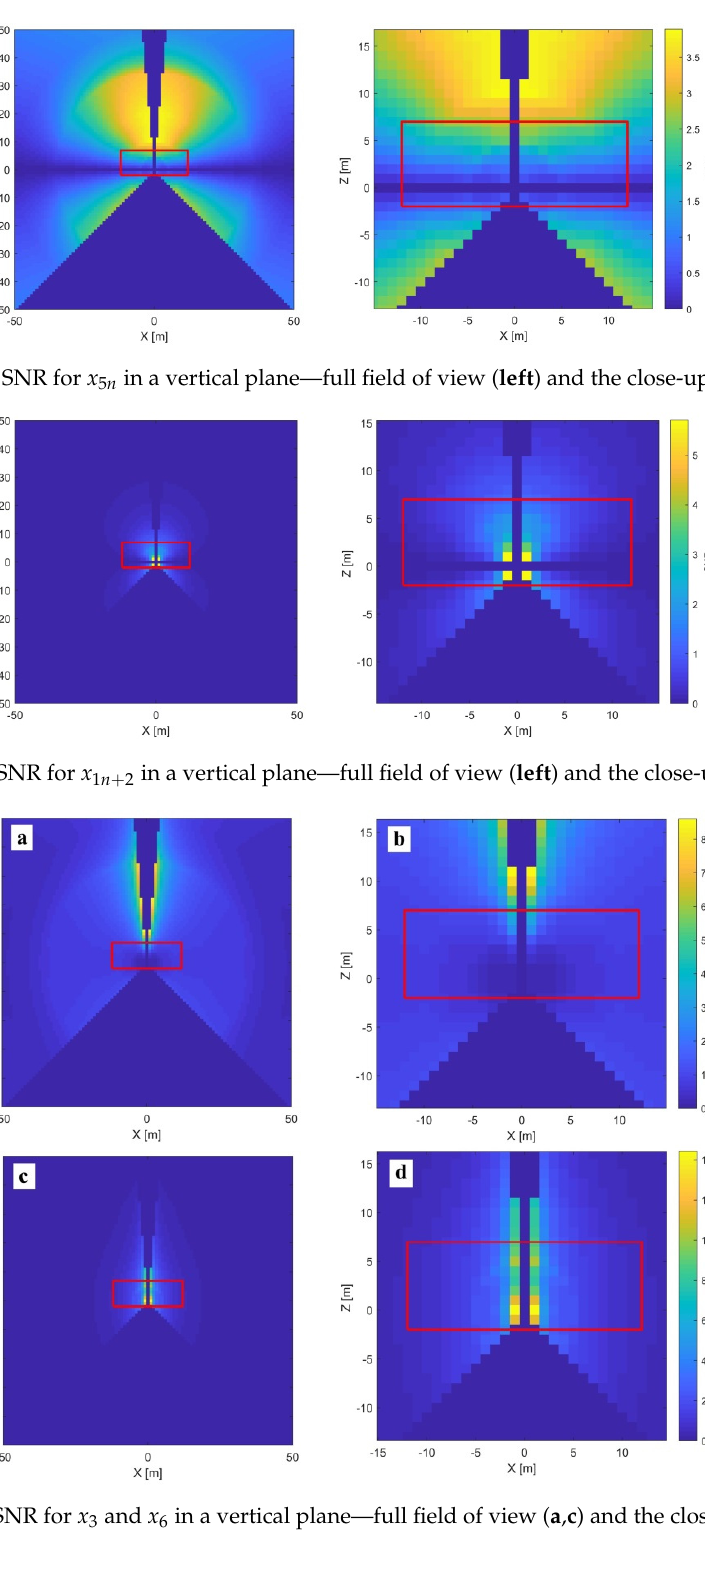
Figure 11. SNR for x 3 and x 6 in a vertical plane—full field of view ( a , c ) and the close-up ( b , d Figure 11. SNR for 𝑥 (cid:2871) and 𝑥 (cid:2874) in a vertical plane—full field of view ( a , c ) and the close-up ( b , d )